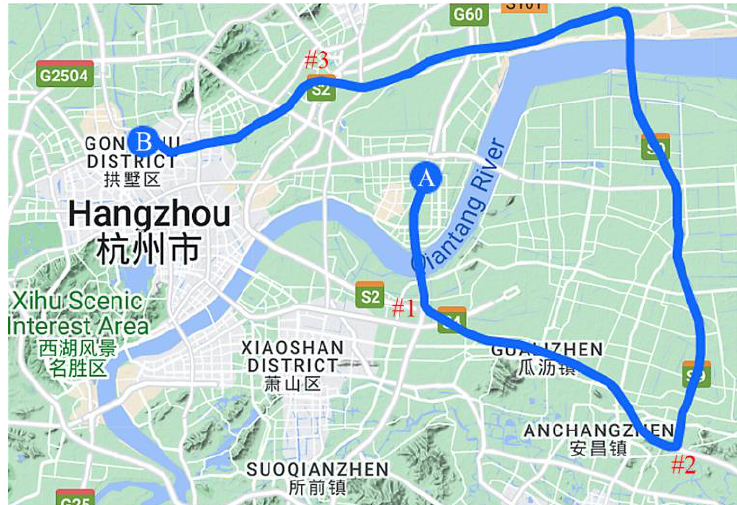
Figure 6. The vehicle trajectory in Experiment 1.